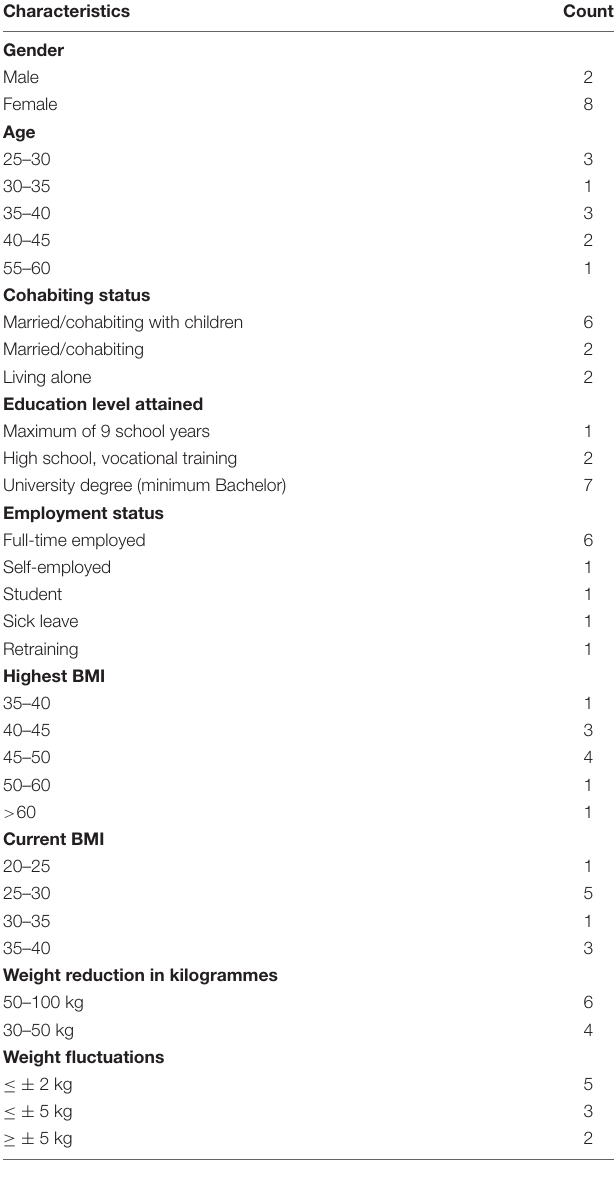
TABLE 1 | Demographic and clinical characteristics of participants.